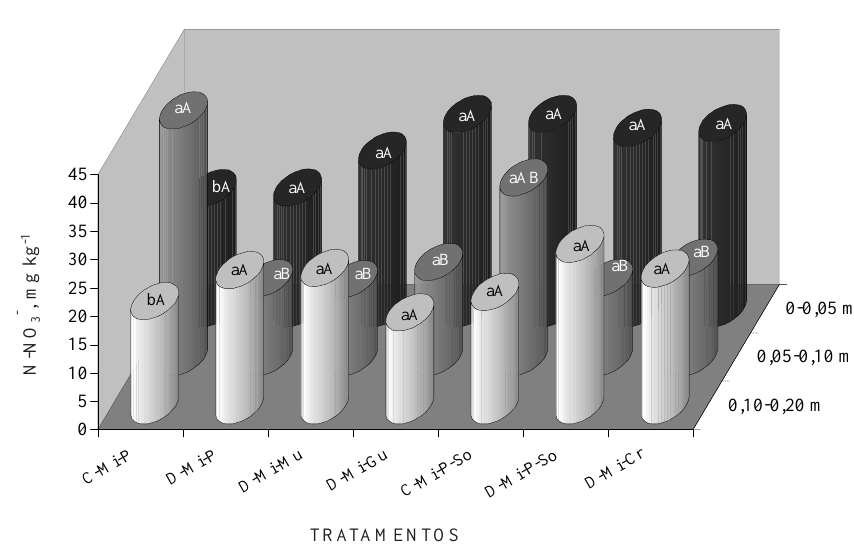
Figura 2. Nitrogênio nítrico em um Latossolo Roxo cultivado em diferentes sistemas de produção por seis anos consecutivos. Letras maiúsculas comparam valores entre tratamentos e letras minúsculas, entre profundidades. C = sistema de semeadura convencional; D = sistema de plantio direto; Mi = milho semeado no verão; So = soja semeada no verão; P = pousio no inverno; Mu = semeadura de mucuna-preta no inverno; Gu = semeadura de feijão guandu no inverno; Cr = semeadura de Crotalaria juncea no